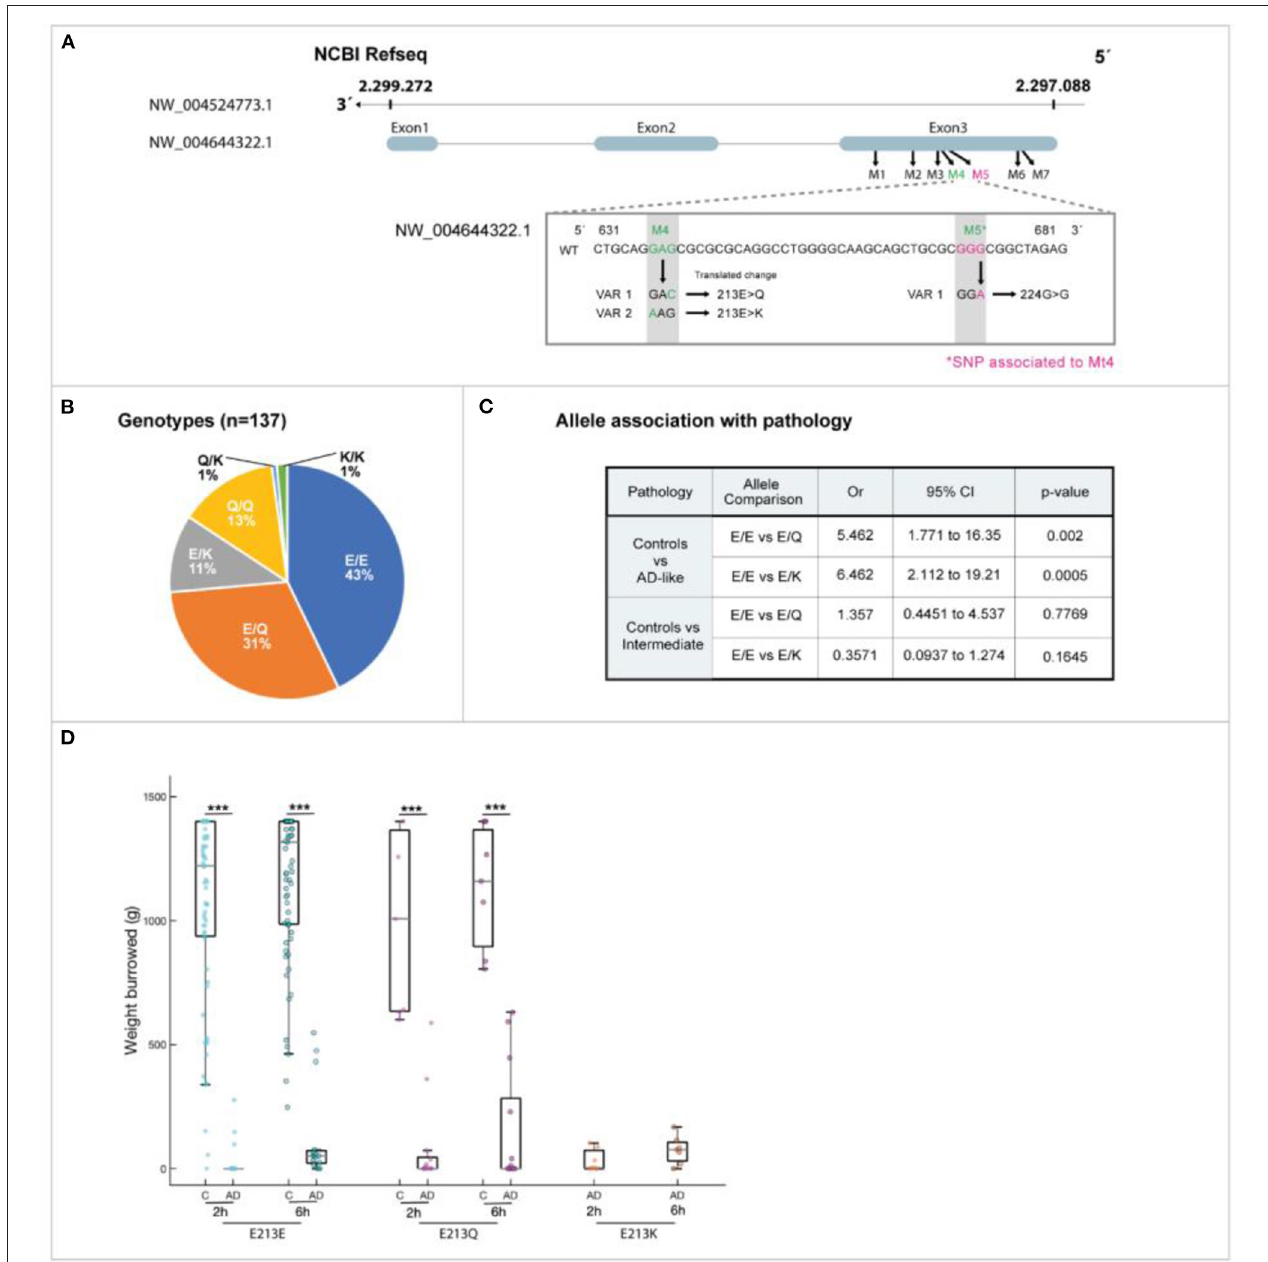
FIGURE 4 | Novel degu Apoe (od Apoe ) mutation: whole-genome sequencing. (A) At position 213, there are three possible residues: glutamic acid (Glu: E), glutamine (Gln: Q), or lysine (Lys: K). Variants 1 and 2 are 213 E > Q and 213 E > K, respectively. The neighboring silent SNP was located 109 base pairs upstream of the missense variant (shown in pink). (B) The genotype frequency in 137 wild degu. (C) Allele association with AD-like pathology in degu. (D) There was a significant difference in the association of the variants E213K and 213 E > Q with AD-like burrowing behavior (Mann–Whitney U test, P <